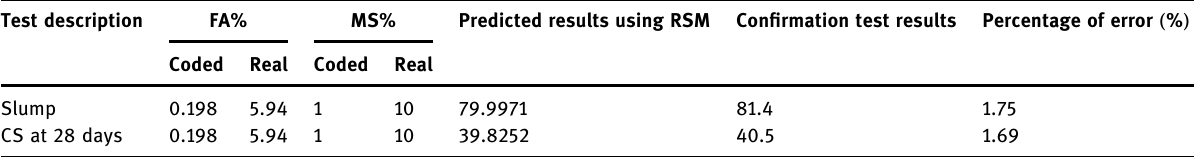
Table 7: Validation test results and the percentage of error Test description FA% MS% Predicted results using RSM Con fi rmation test